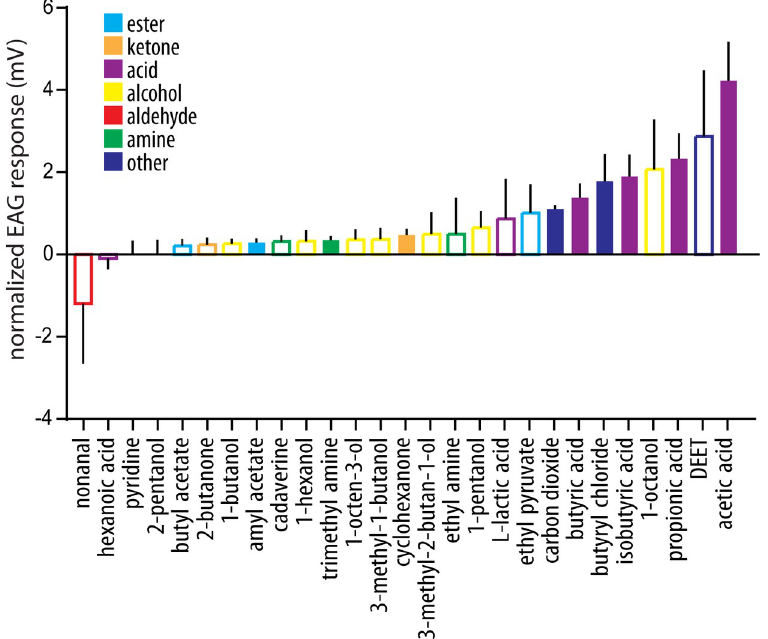
Fig 3. Antennal responses from Rhodnius prolixus . Ecologically relevant odorants (see S1 Table) were applied to the insect antenna, and evoked responses were measured through electroantennogram analysis. Responses were normalized to their corresponding solvent response (see Methods). Filled bars represent statistically significant responses (one-sample t test against zero: p < 0.05, n = 7–10 for each odor tested).